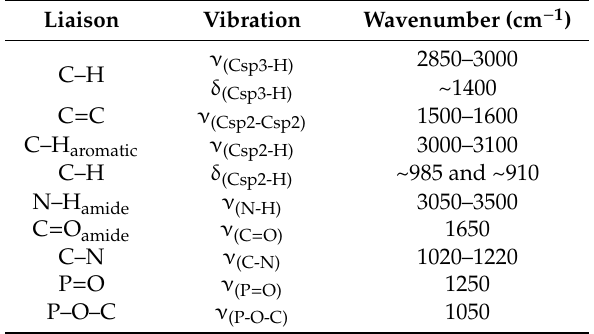
Table 2. Bands assignments (cm − 1 ) in the IR spectrum of compound ( 3 ).